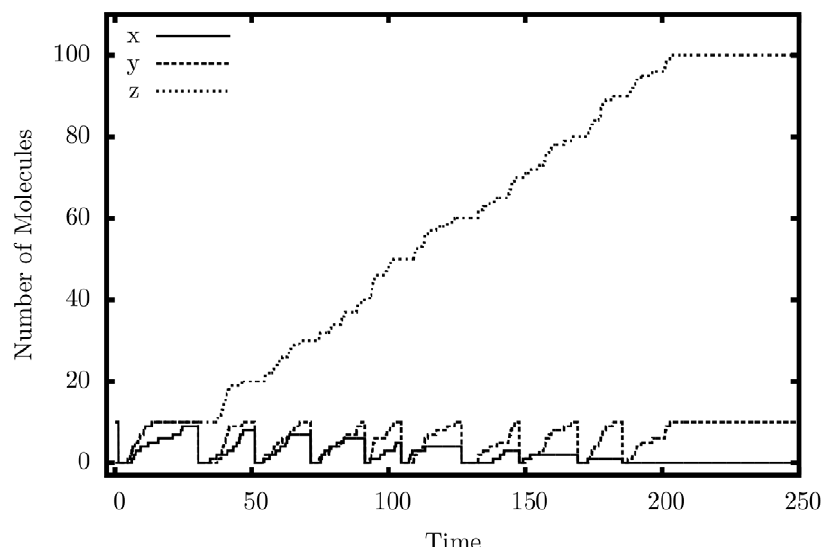
Figure 4. Simulation output of the multiplication construct. x ~ 10 , y ~ 10 .